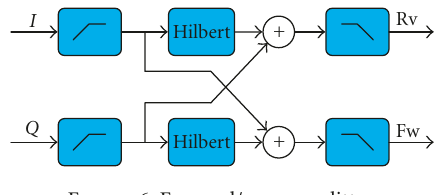
Figure 6: Forward/reverse